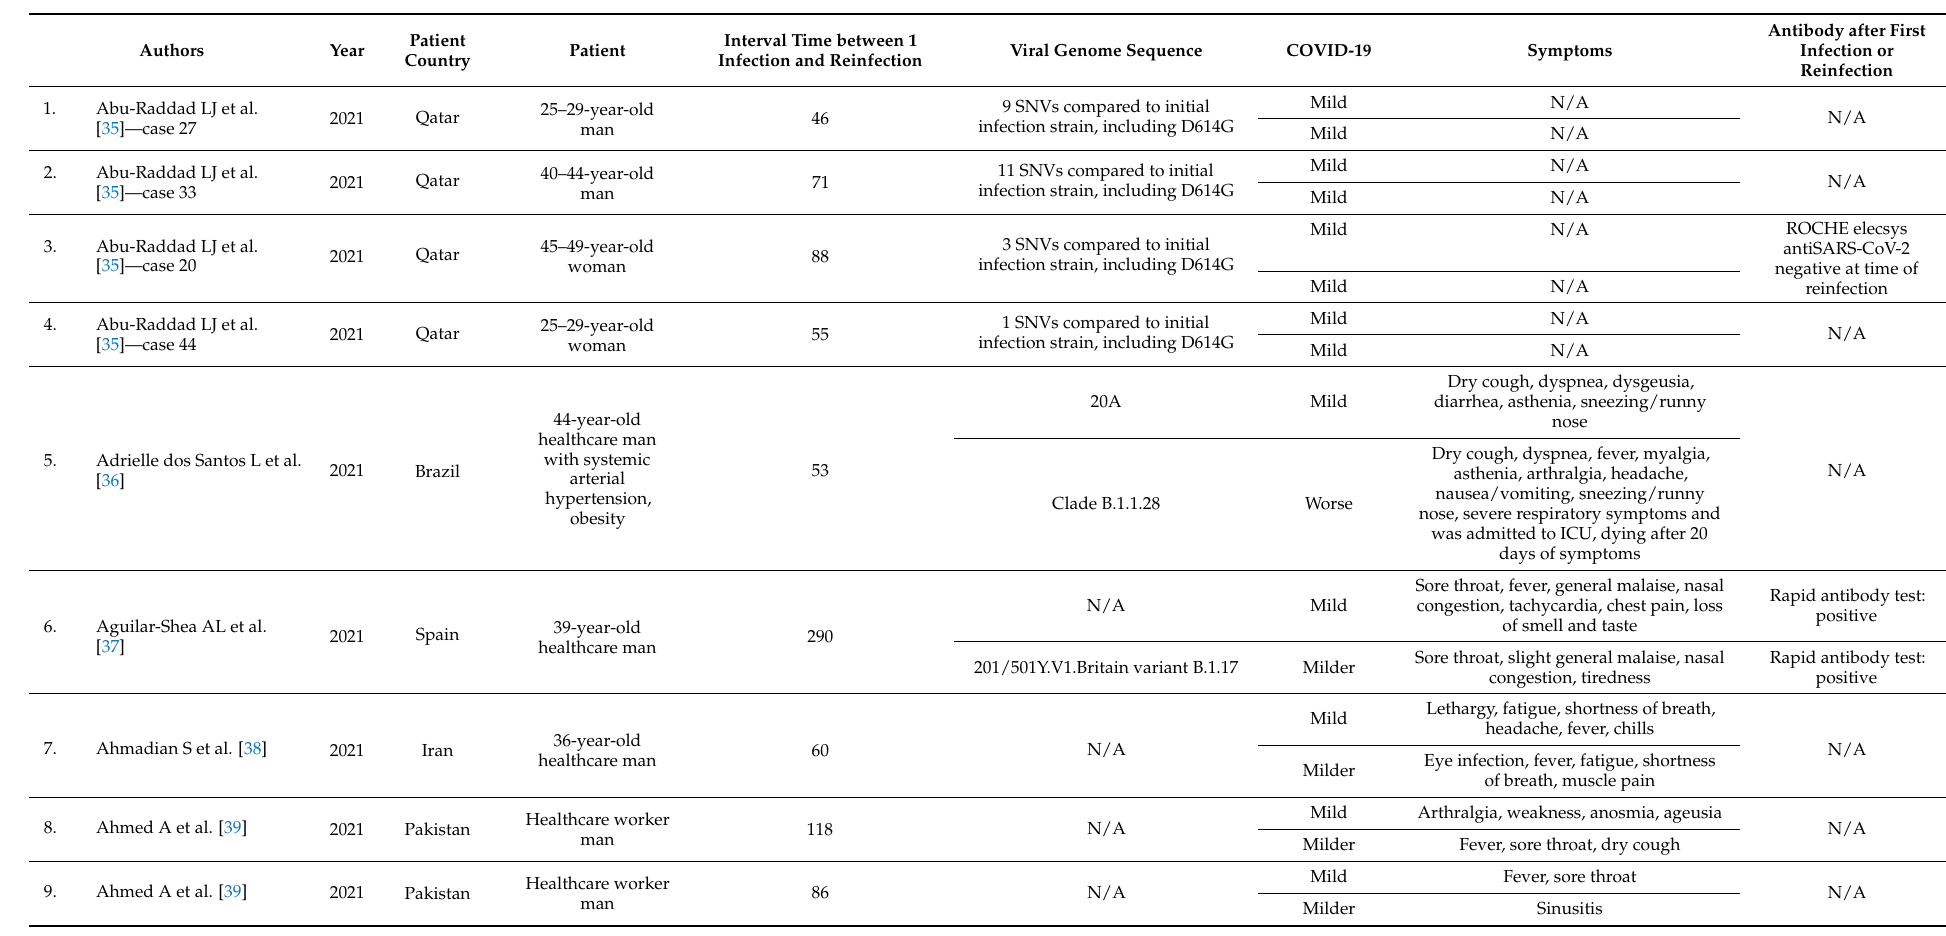
Table 2. Cases of SARS-CoV2 reinfection in the international literature (all cases were again positive for SARS-CoV-2 after complete symptomatic recovery in addition to negative RT-PCR test for SARS-CoV-2, according to WHO recommendations